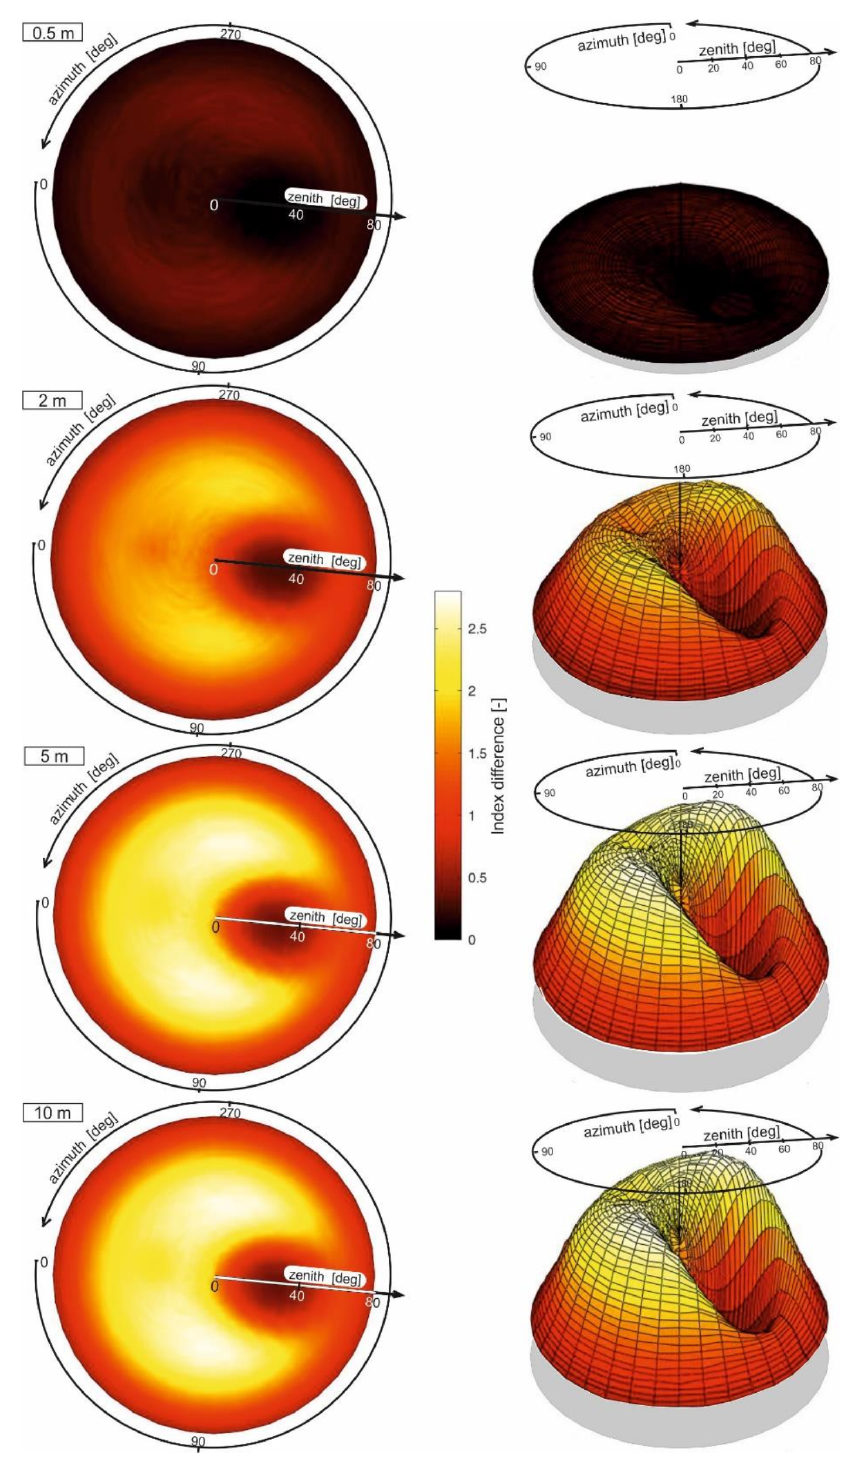
Figure 3. Spectral difference index depending on the thickness of the oil-polluted layer for various viewing